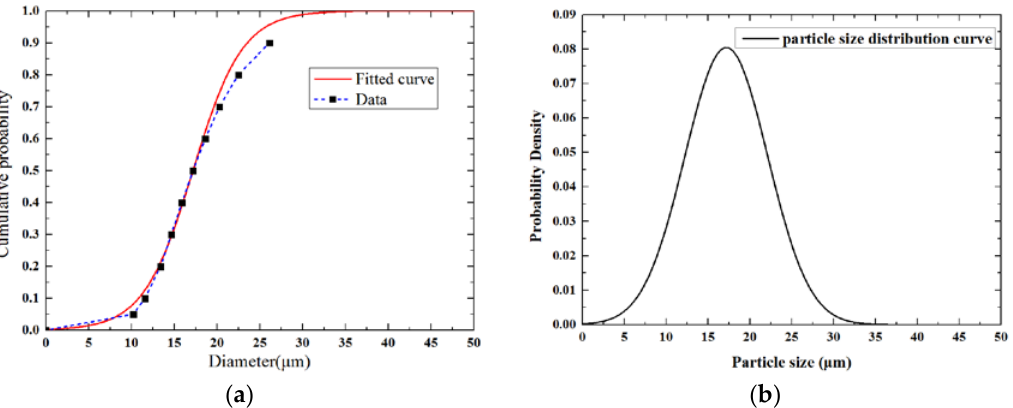
Figure 5. Raw data shown in Table 2 and fitted curve: ( a ) Cumulative density curve; ( b ) Probability density distribution curve.